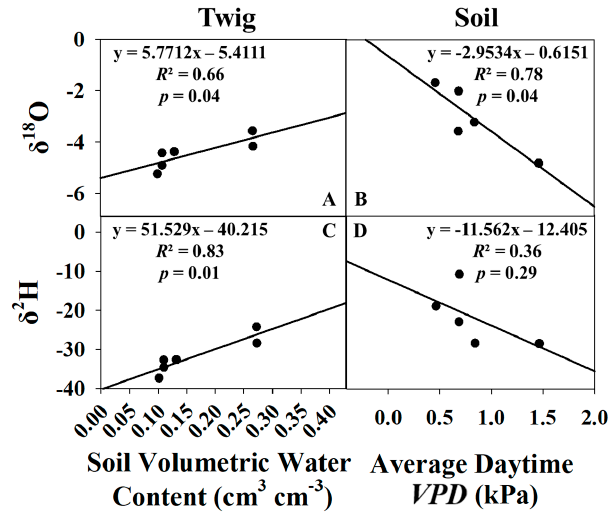
Figure 8. Linear regressions of δ 18 O vs. average soil moisture ( A ) and average daytime VPD ( B ), δ 2 H vs. average soil moisture ( C ), and average daytime VPD ( D ) for the growing season only.